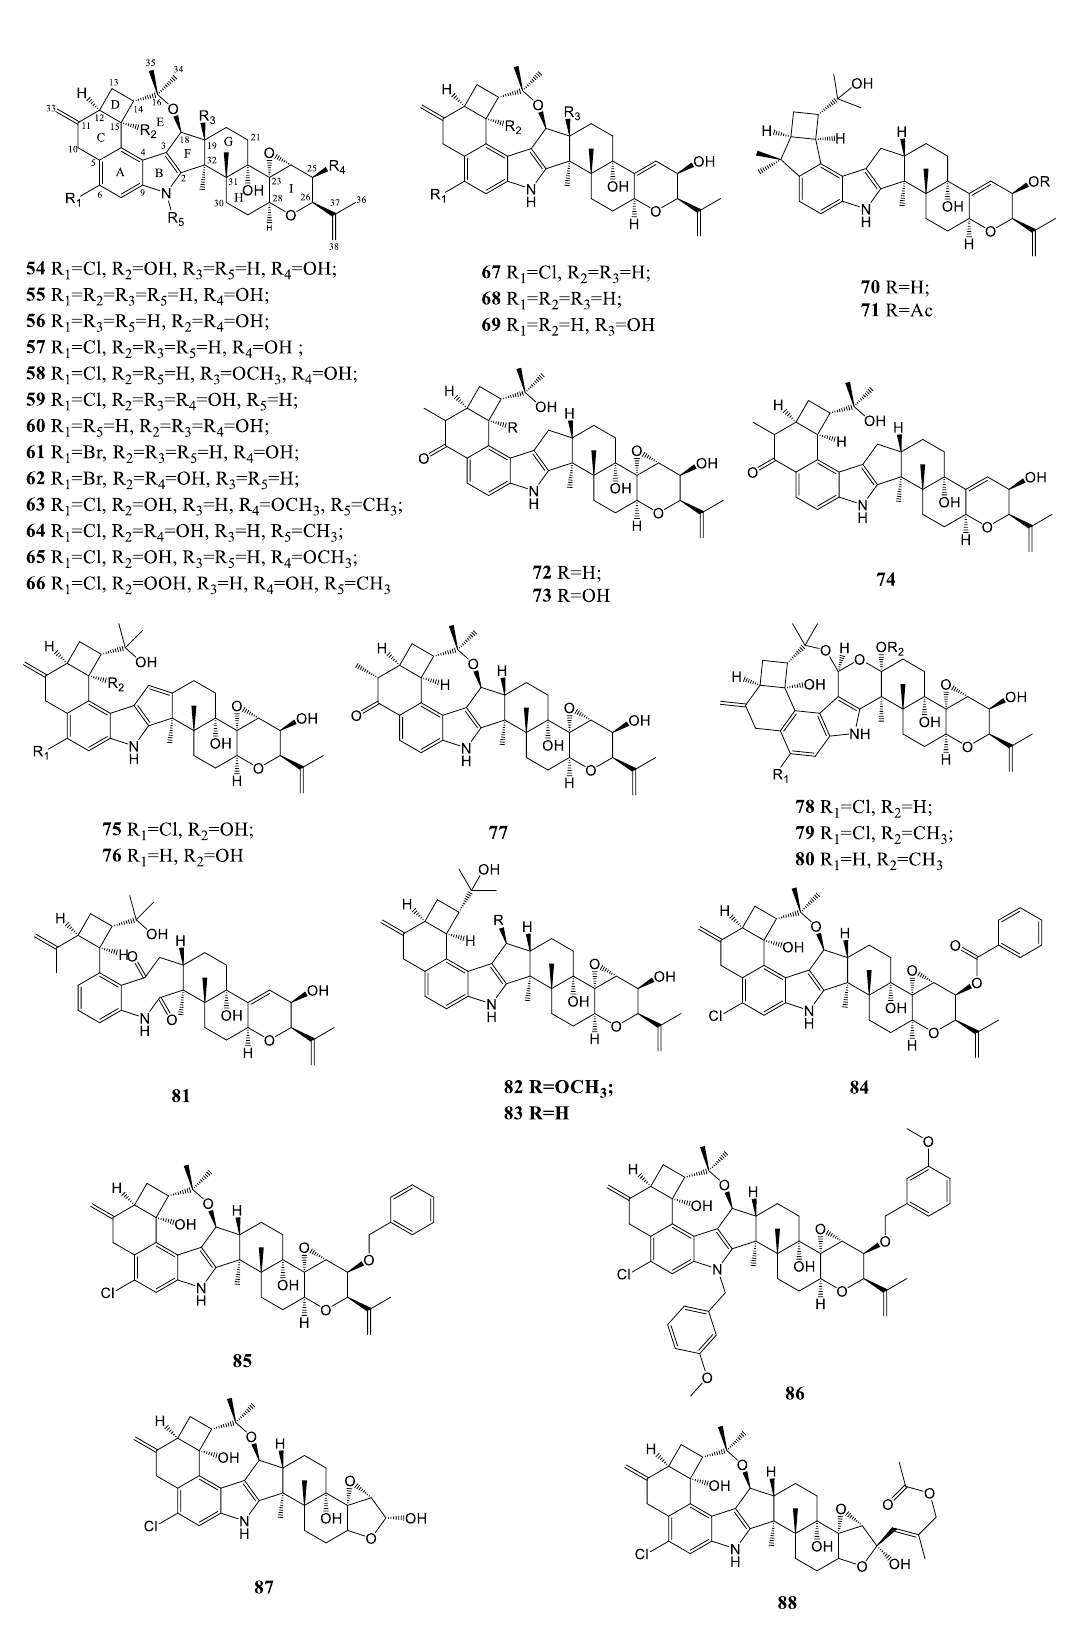
Figure 4. Paxilline-like indole diterpenoid compounds ( 54 – 88 ).